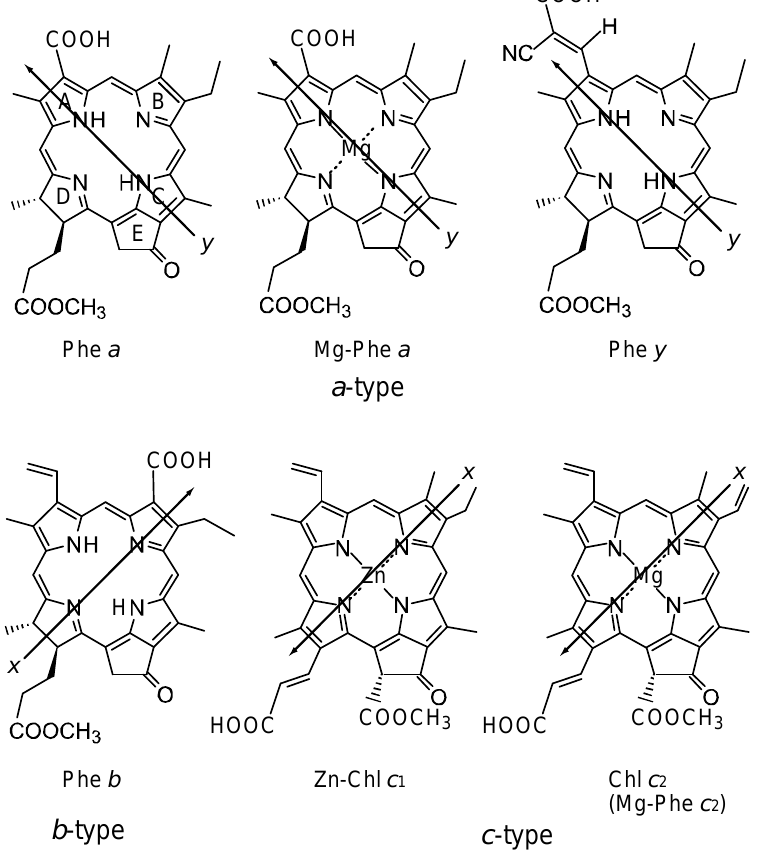
sensitizers give rise to the highest performance, i.e. , Zn-Phe c c ) ( J = 9.9, η = 3.8). 2 sc Figure 43. Chemical structures of Phe’s and metal-Phe’s: Phe a , Mg-Phe a , Phe y are classified into the a -type sensitizer, Phe b , into the b -type sensitizer, and Zn-Phe c c (Mg-Phe c ), into the c -type sensitizer. Each arrow points to the anchoring carboxyl 2 2 group; directions x , y are defined in accord with those of the Q in the chlorin macrocycle of Phe a .